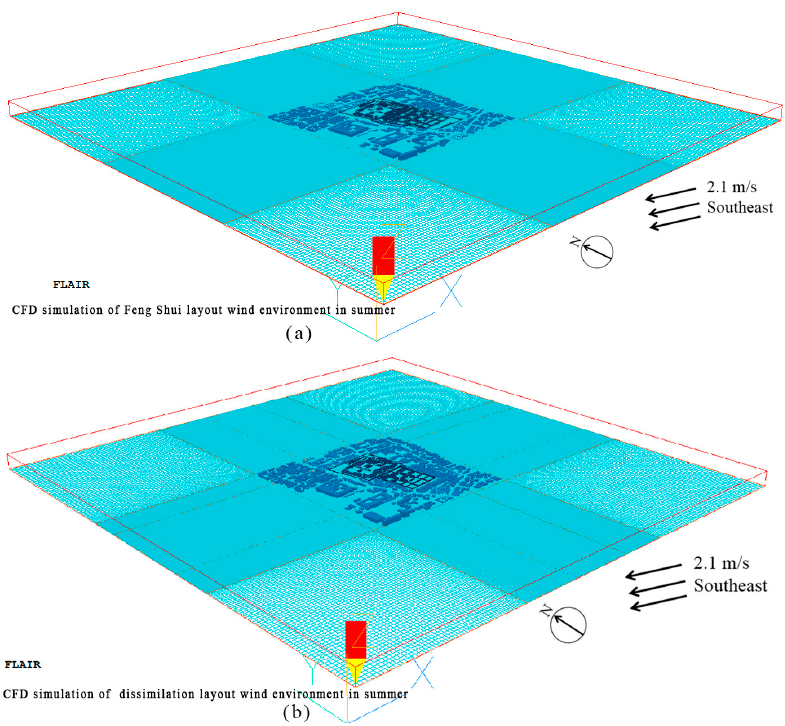
Figure 4. PHOENICS mesh settings: ( a ) the feng shui layout; ( b ) the dissimilation layout.